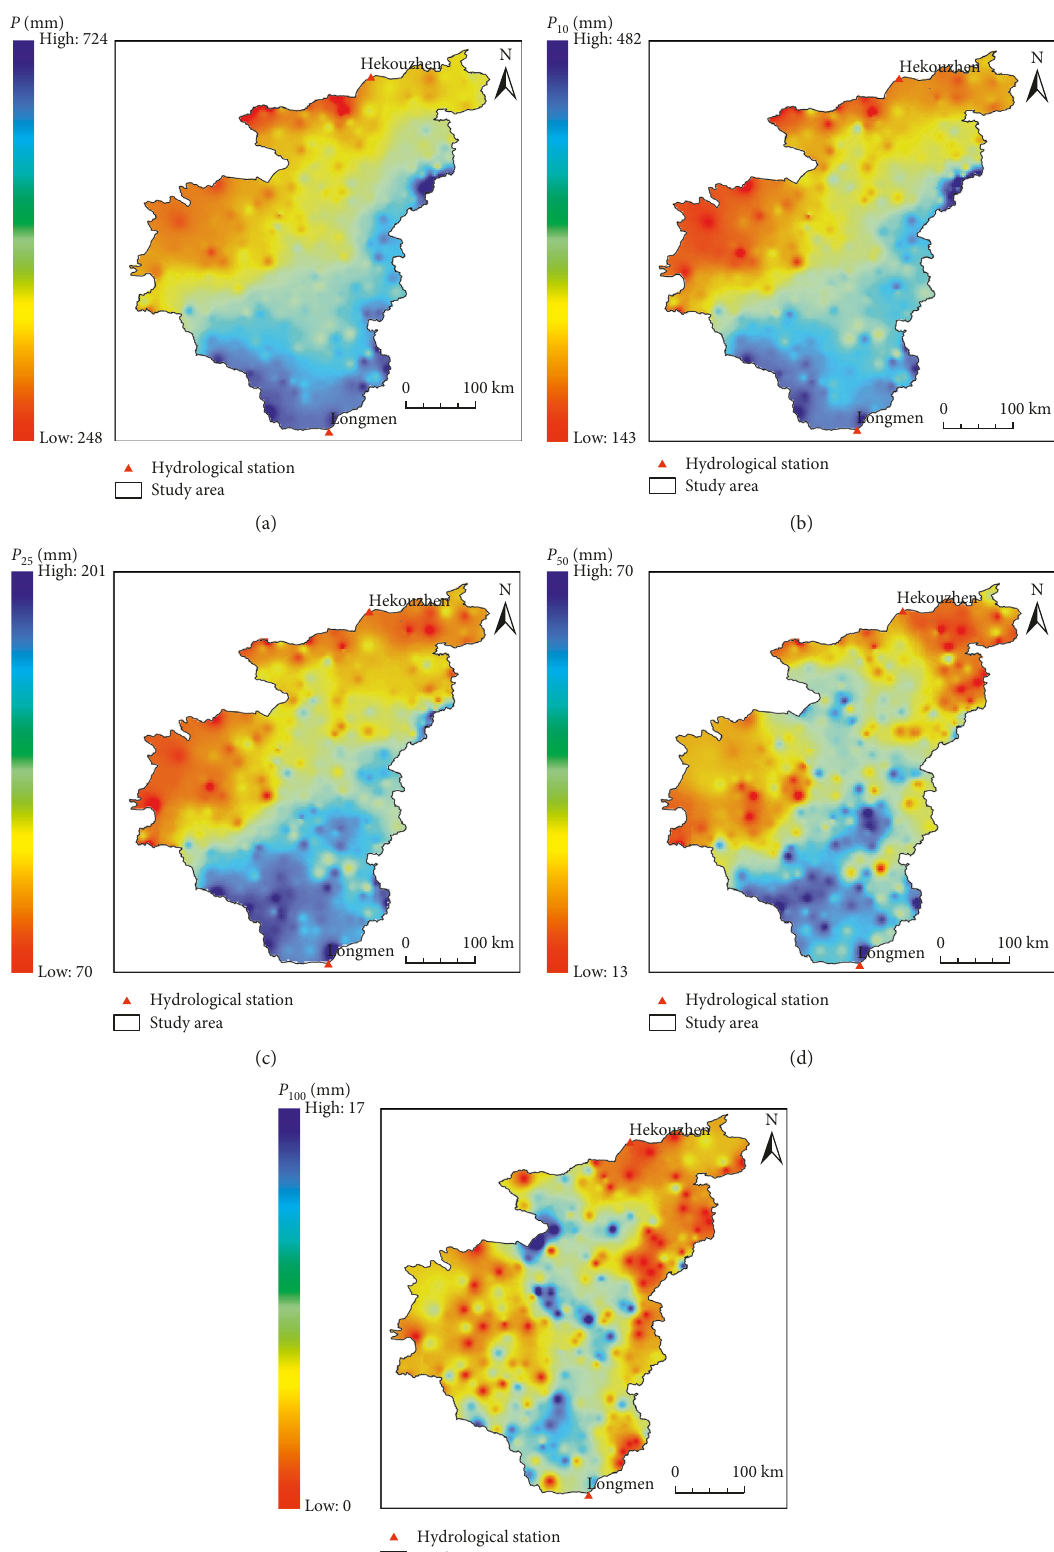
Figure 2: Spatial distribution of (a) P , (b) P